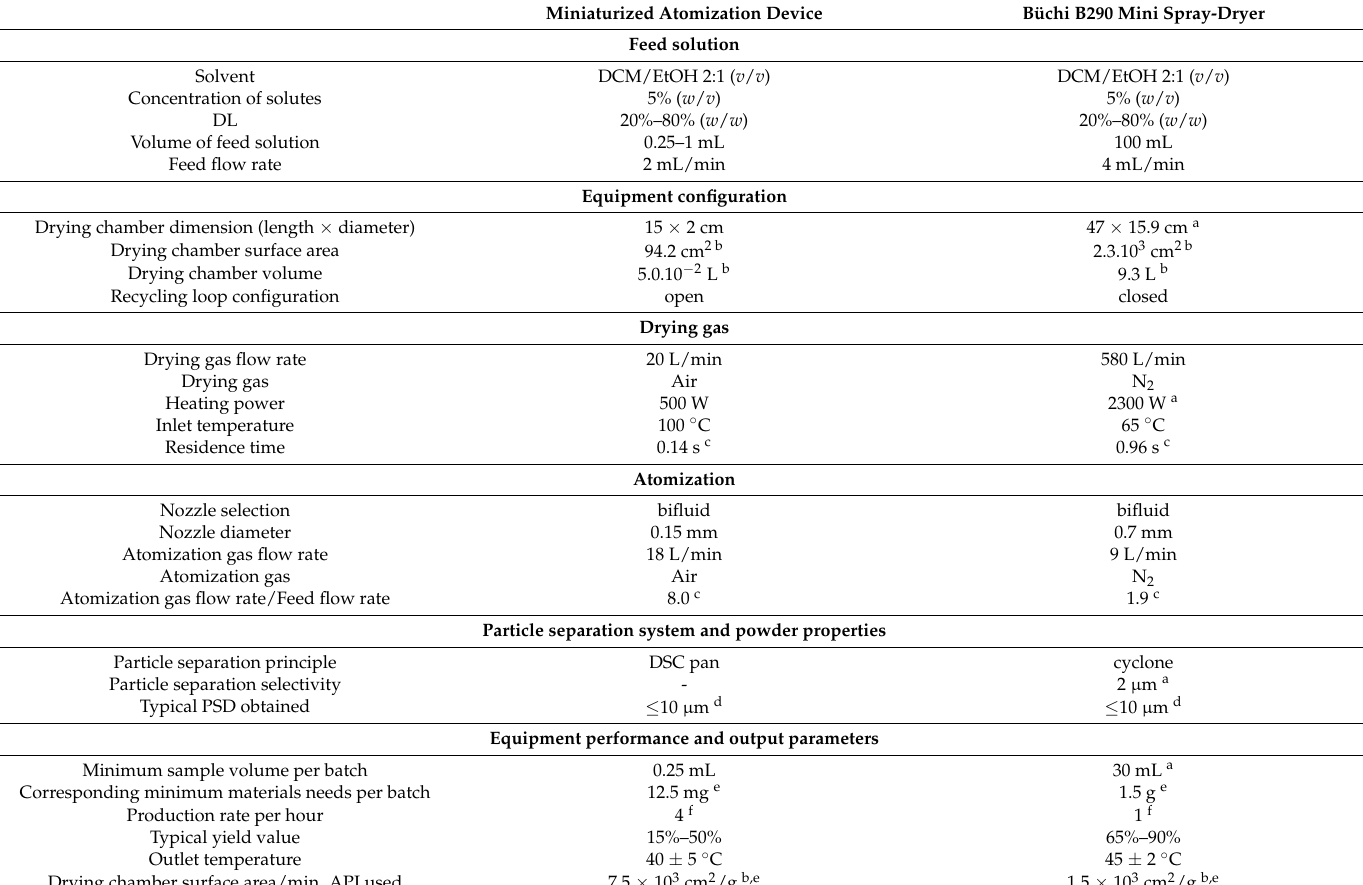
Table 1. Comparison of equipment operational parameters, equipment design, and performance between miniaturized atomization device and laboratory-scale Büchi B290 mini